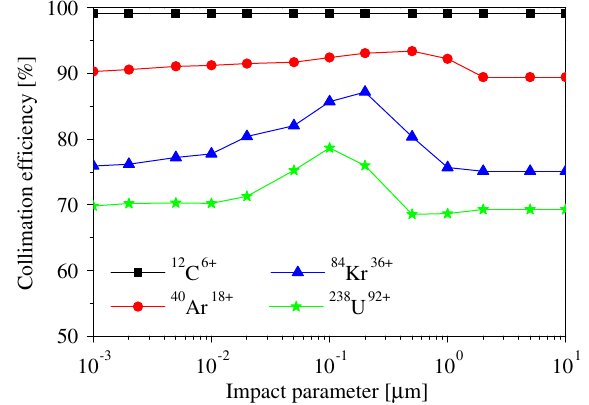
FIG. 9. Dependence of the collimation efficiency on the retraction